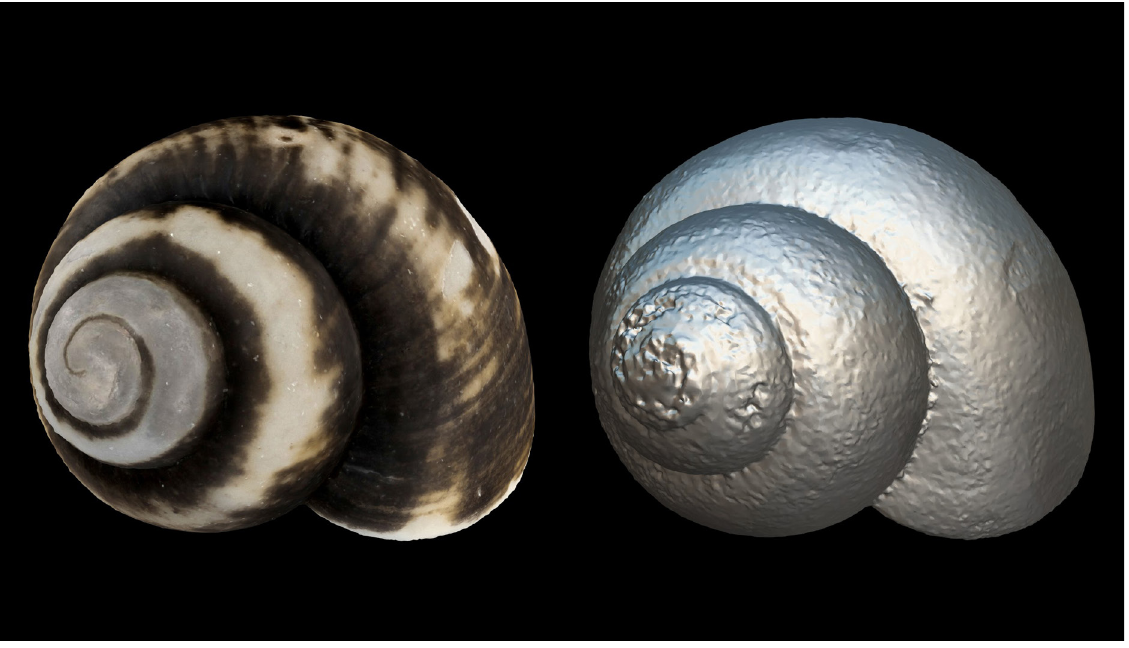
Fig. 3.14. 3D model, with texture on the left and Matcap on the right, of the mollusk Gabbiella humerosa edwardi (size: 6 mm) generated in Agisoft Photoscan based on focus-stacked images.